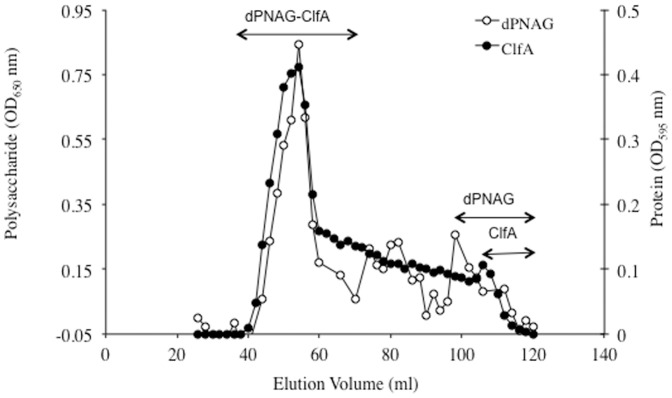
Size exclusion chromatography profile of dPNAG conjugated to ClfA through a Superose 6 gel column.Fractions were assayed for polysaccharide by the hexosamine assay (OD650 nm) and for protein with the Bradford assay (OD595 nm). Double-headed arrows indicate the fractions containing conjugated dPNAG and ClfA, as well as where the unconjugated polysaccharide (dPNAG) and protein (ClfA) eluted.